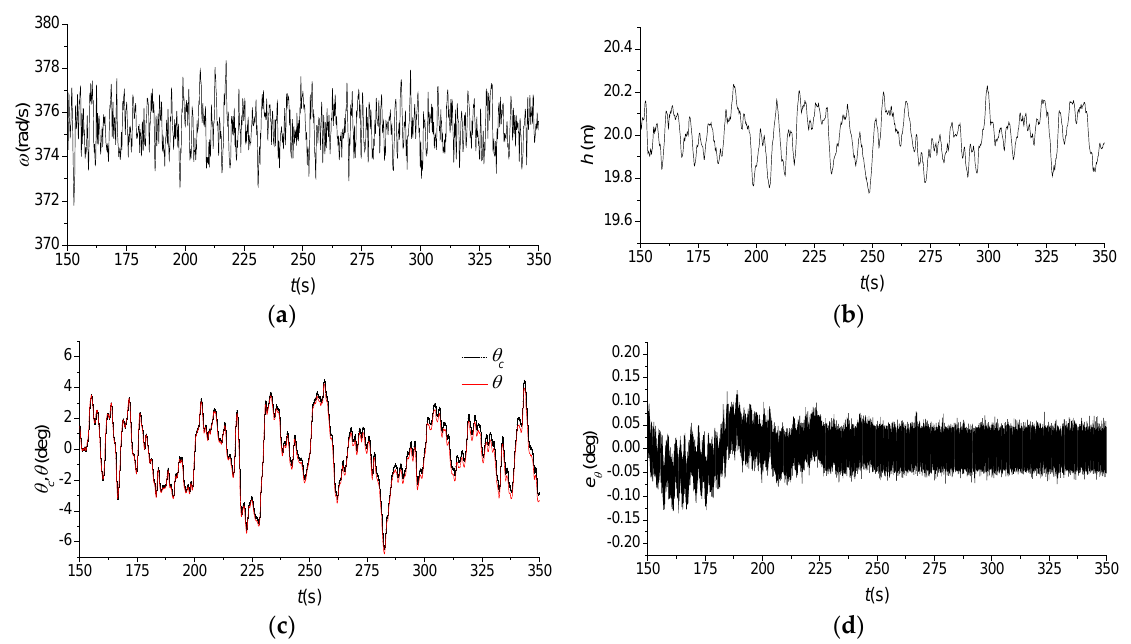
Figure 13. The experimental results using the existing adaptive controllers in the altitude loops, and the PID controller with the closed-loop rotational speed control structure in the altitude loop: ( a ) ω ; ( b ) h ; ( c ) θ c and θ ; ( d ) e θ .